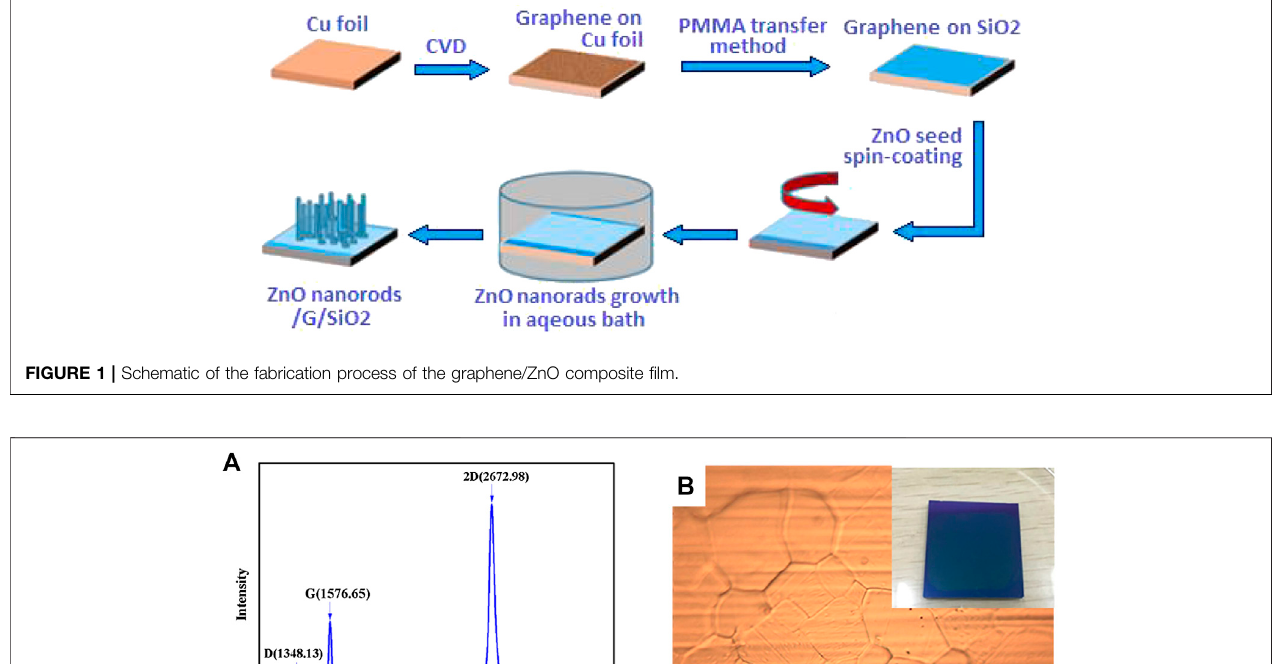
Frontiers in Physics |